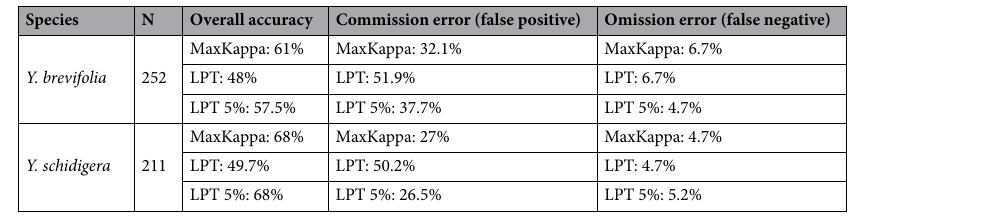
Table 2. Anomalous bloom prediction test